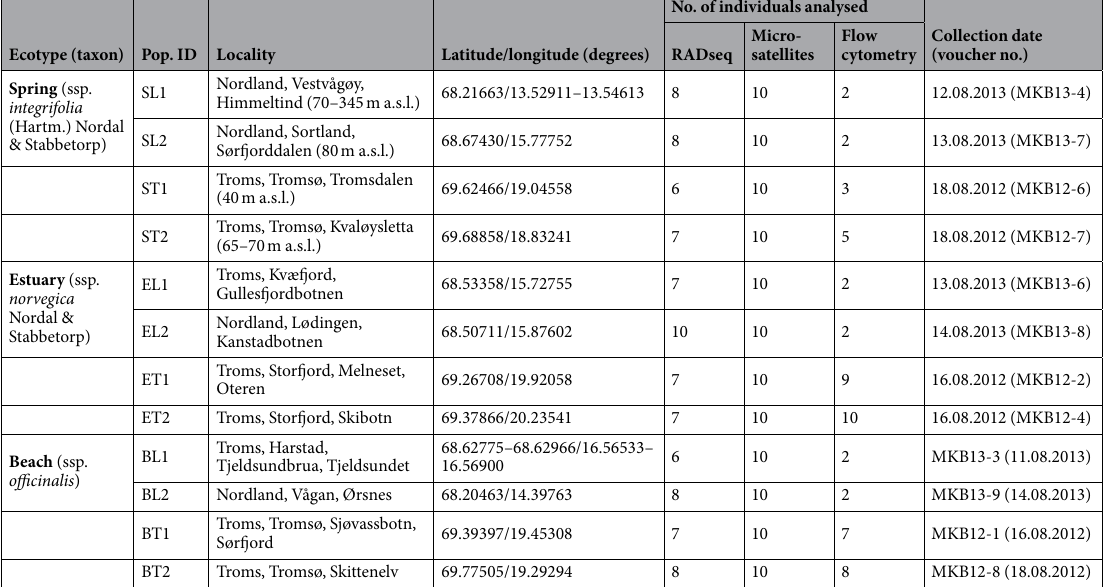
Table 1. Collection data for Cochlearia officinalis L. populations from Northern Norway. Pop ID: Population ID according to ecotype (B = beach, E = estuary, S = spring) and geography (T = Troms, L = Lofoten). When m a.s.l. is not given, the population was sampled at sea level. Number of individuals used for RADseq, microsatellite analyses and flow cytometry is given. Collectors: M.K. Brandrud, I. Nordal, A.K. Brysting.